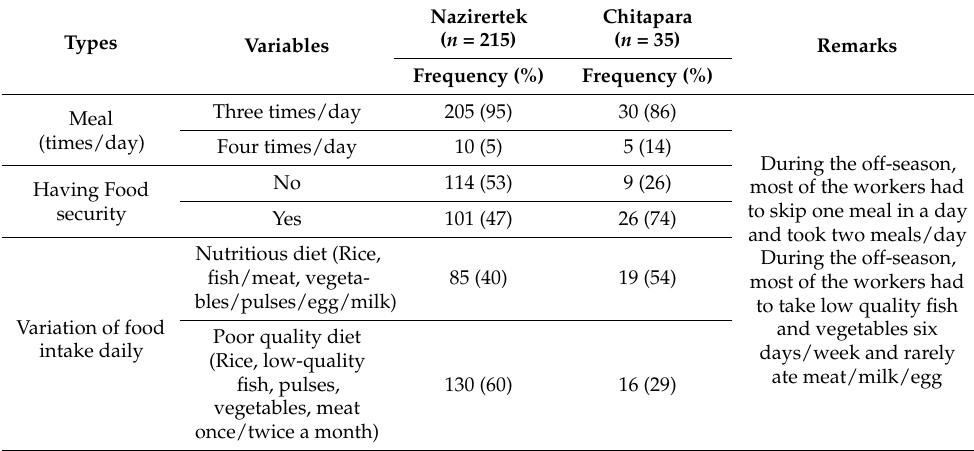
Table 4. Nutrition and food consumption ratio of the respondents of the studied areas.